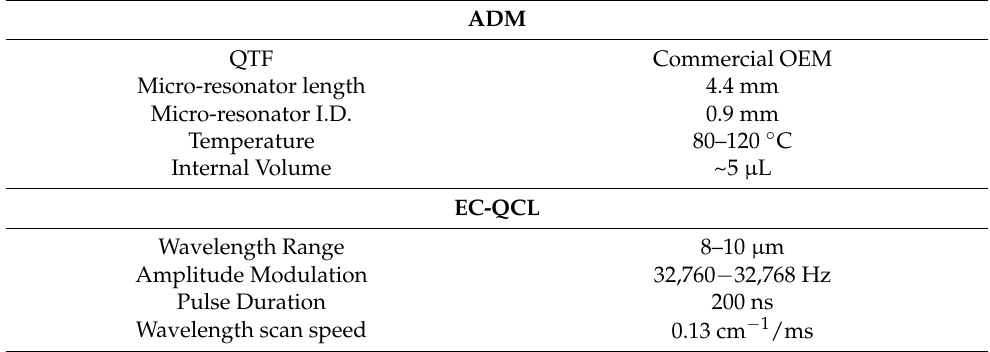
Table 3. Working parameters of the QEPAS